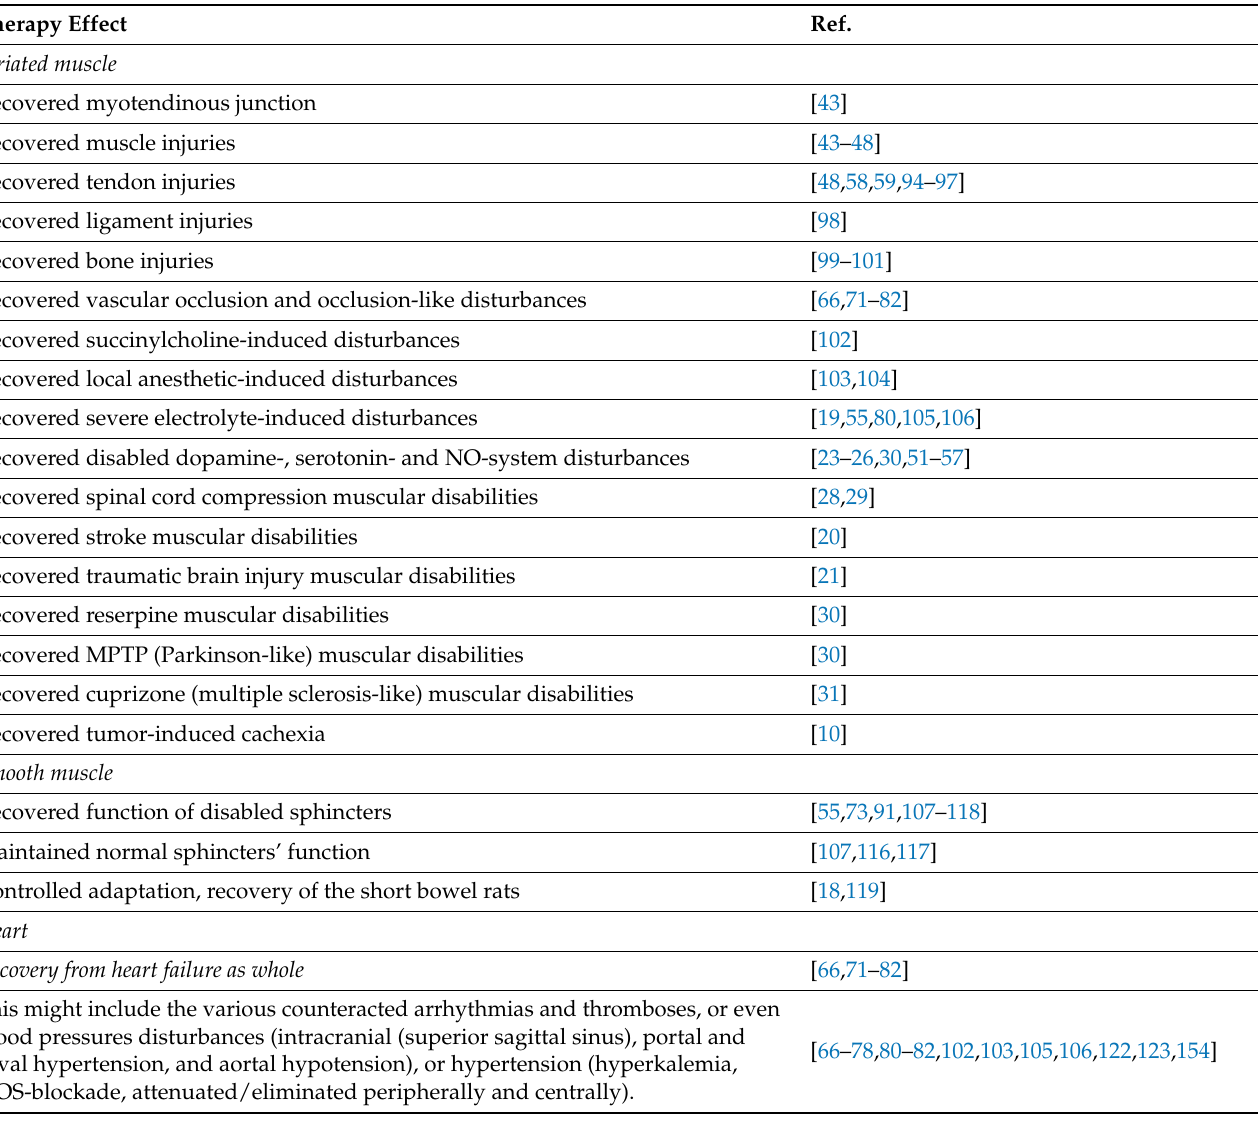
Table 1. Multimodal muscle axis presentation with BPC 157 therapy confronted with various muscu- lar disabilities. Note, BPC 157 therapy ranges within 10 µ g and 10 ng/kg (GEPPPGKPADDAGLV, molecular weight 1419; Diagen,